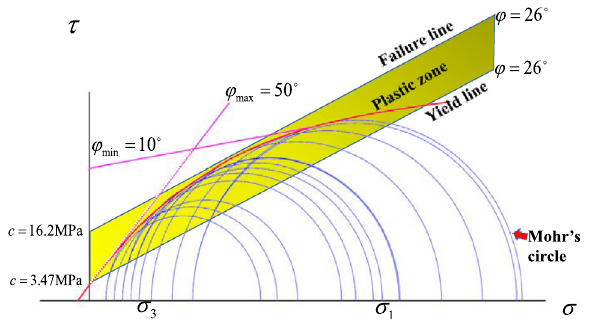
Fig. 2 Determination of two criteria for a yield line with cohesion 3.47 MPa and internal friction angle 26 (cid:3) and a failure line with cohesion 16.2 MPa and internal friction angle 26